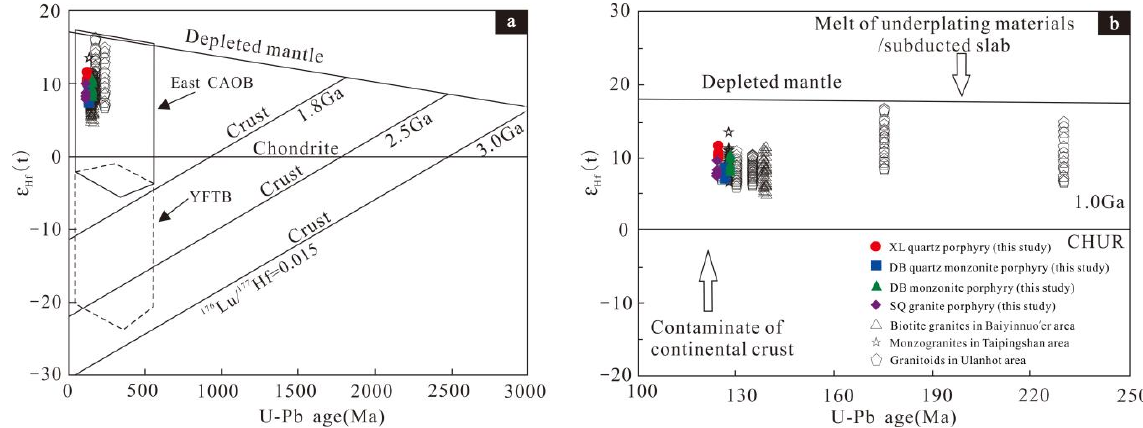
Figure 7. Zircon Hf isotopic composition of the Early Cretaceous intrusive rocks in the northern part of Ulanhot area. ( a ) ε Hf (t) versus U–Pb age (Ma) diagram; ( b ) the detailed distribution of samples in the ε Hf (t) versus U–Pb age (Ma) diagram. CAOB: Central Asian Orogenic Belt; YFTB: Yanshan Fold and Thrust Belt (Yang et al. [104]). ε Hf (t) values of the granitoids in the Ulanhot, Taipingshan, and Baiyinnuo’er areas are from Zhou et al. [23], Lu et al. [64], and Wei et al. [18], respectively.